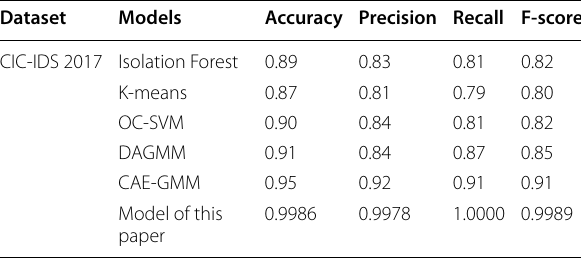
Table 5 Comparison of the results of each anomaly detection algorithm under the CIC-IDS 2017